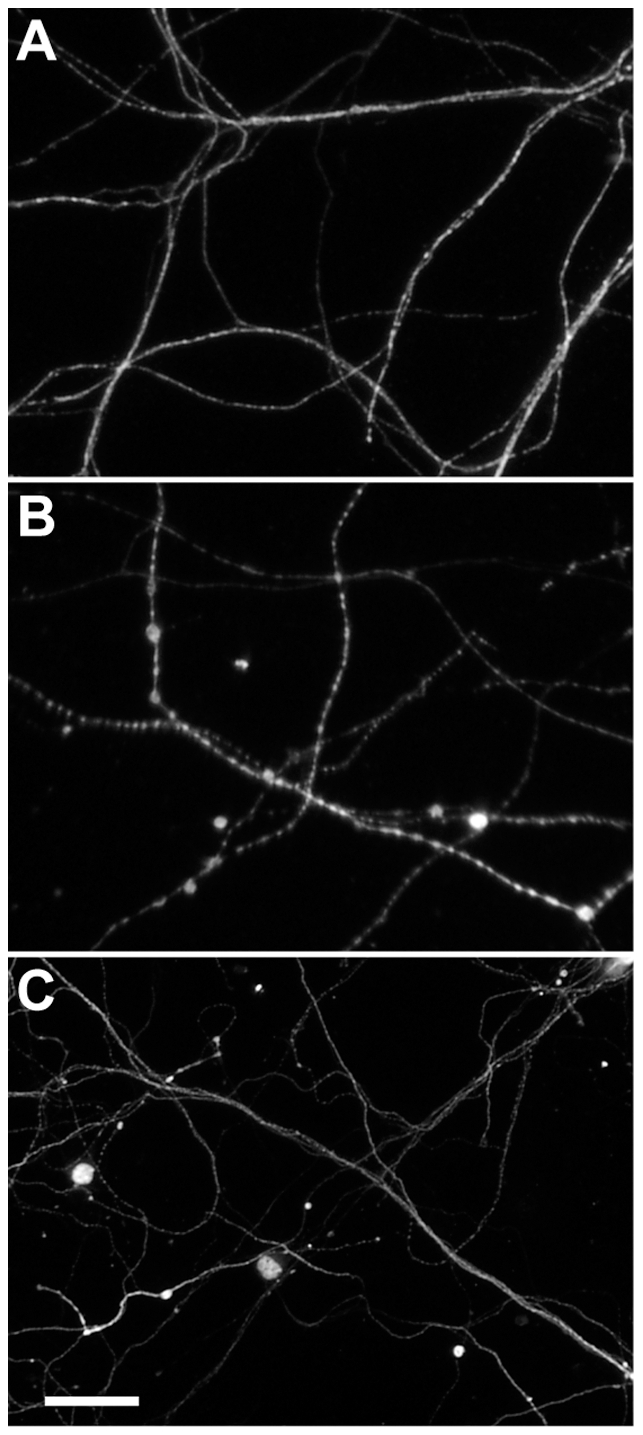
SCILs directly injure stressed axons in vitro in a perforin-dependent manner.Perforin-competent but not perforin-deficient SCILs induce beading and fragmentation of neurofilaments in cortical neuron axons in vitro in the absence of viral infection. (A) Neurofilament staining in cortical neuron axons not exposed to SCILs. (B) Beading and disintegration of neurofilaments elicited by perforin-competent SCILs incubated with cortical neurons for 120 min. (C) Perforin-deficient SCILs did not trigger axon injury. Scale bar in (C) is 50 µm and refers to (A–C).